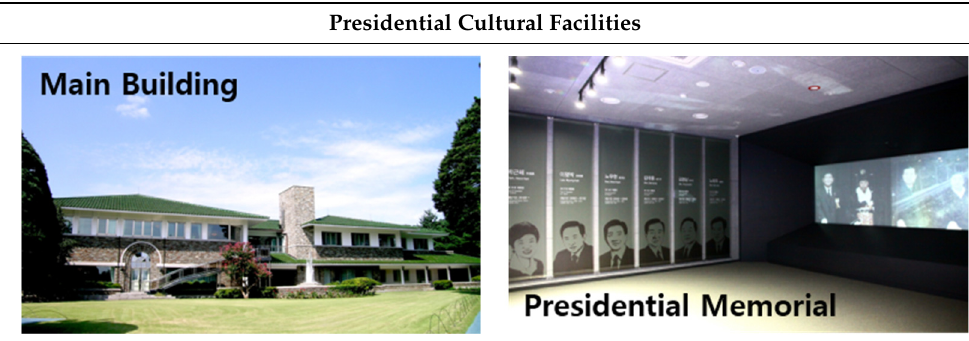
Figure 1. Bird’s-eye view of Cheongnam-dae. Note: http://www.jbnews.com/news/articleView.html?idxno=1278342, (accessed on 20 May 2021). Table 1. Major facilities and programs of Cheongnam-dae.